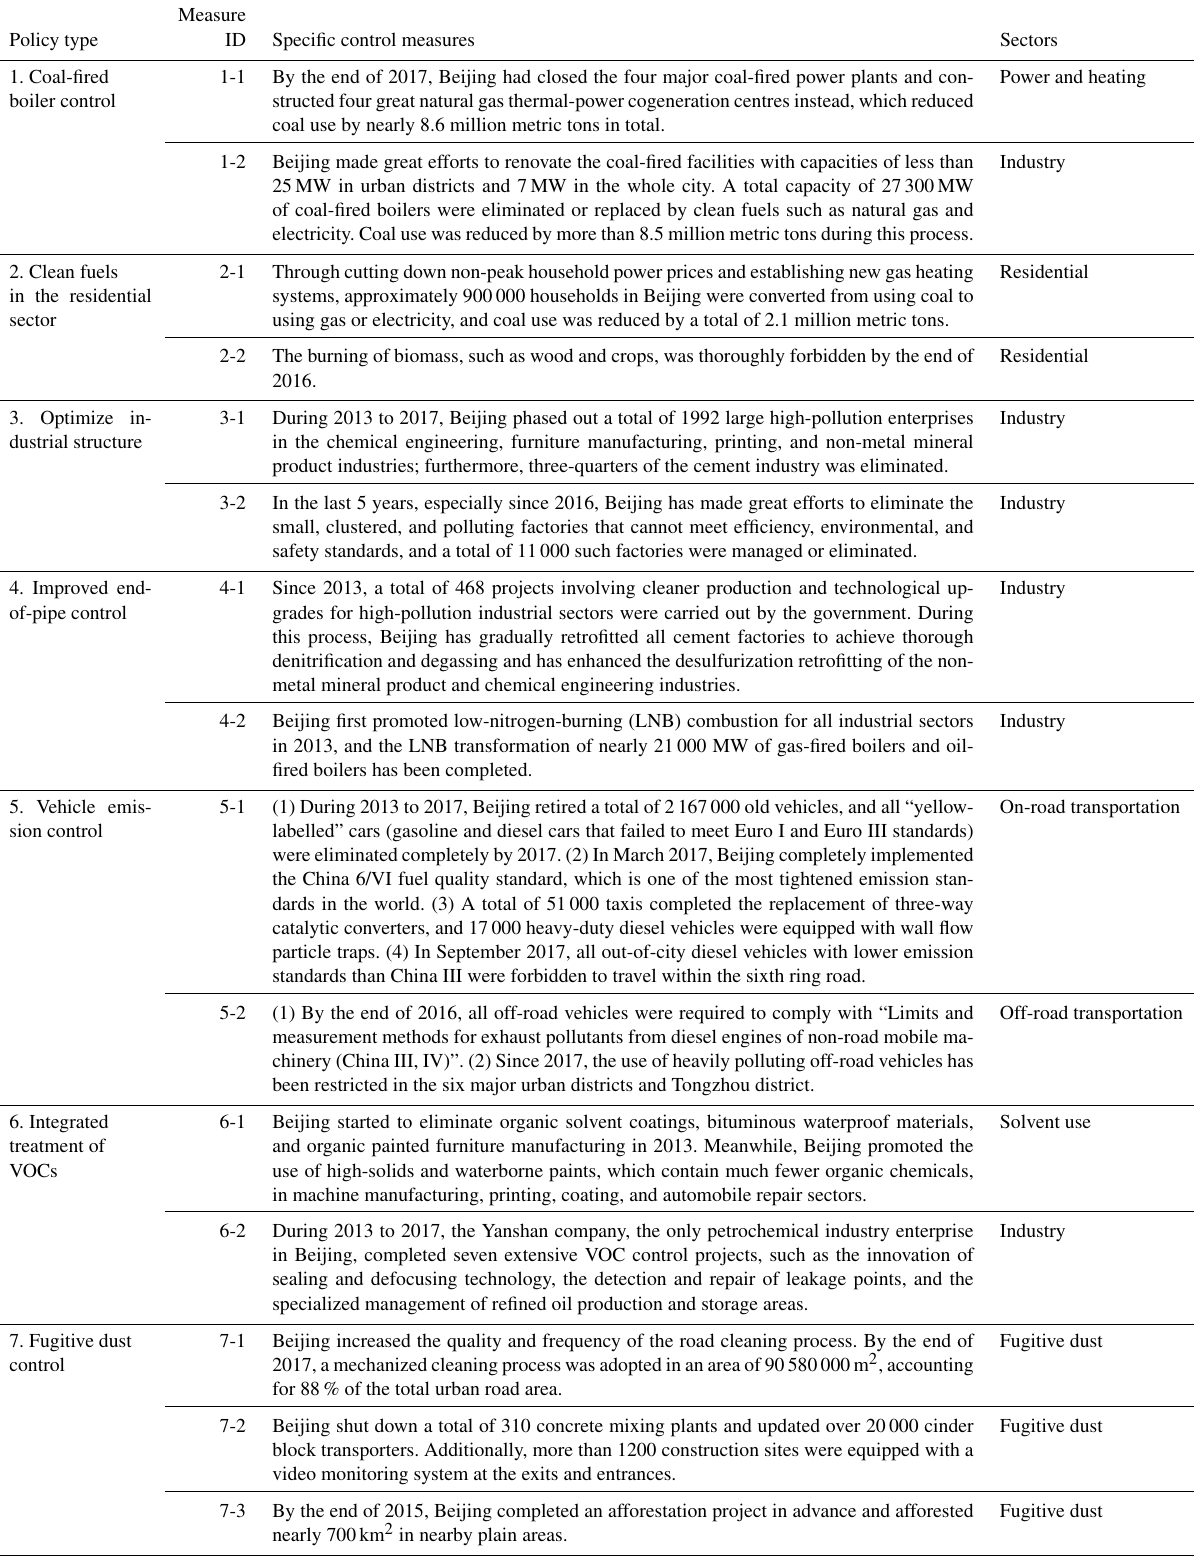
Table 1. Summary of emission control measures implemented in the Beijing Action Plan